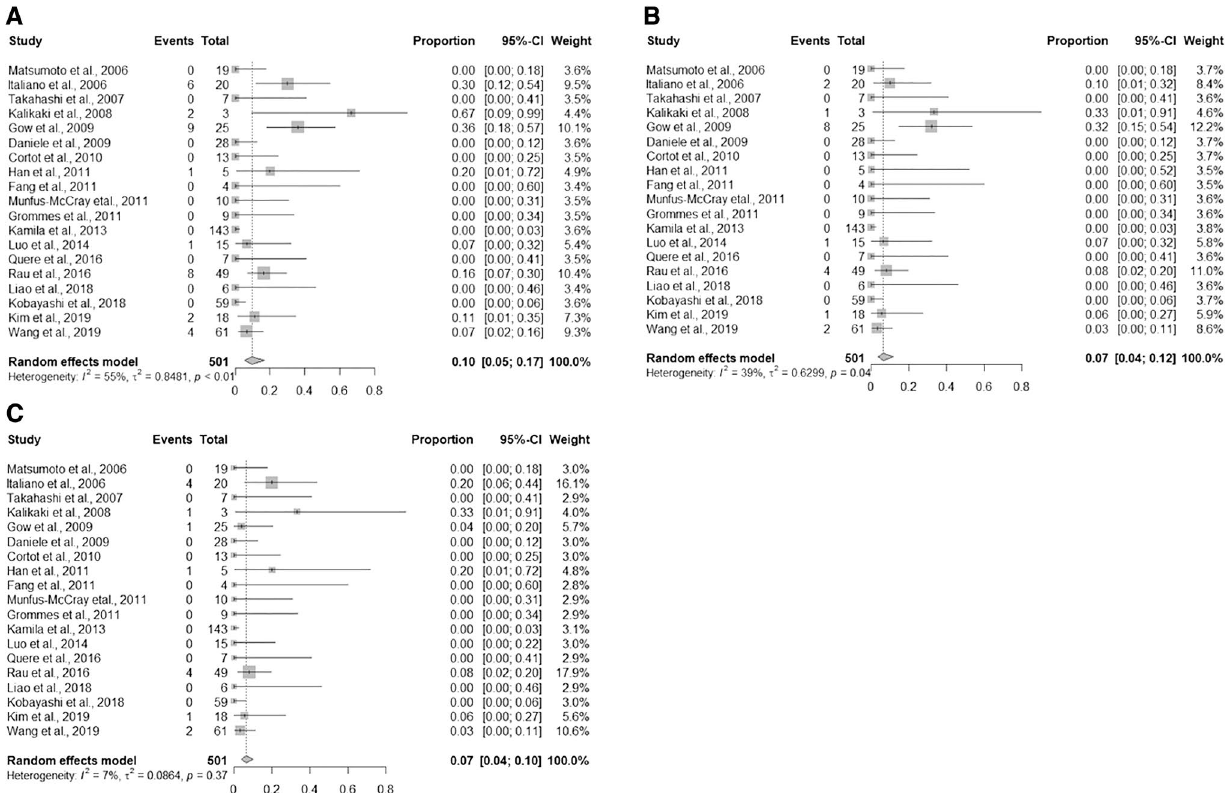
Fig. 1 Forest plots of primary lung tumor and brain metastasis EGFR status. A Lung cancer/brain metastasis EGFR discordance, B BM EGFR gain, and C BM EGFR loss. In the forest plot, square box corresponds to proportions of individual study and horizontal line 95% confidence interval. Dimension of each box represent the weight of each study. The diamond represents pooled estimate with 95% confidence interval